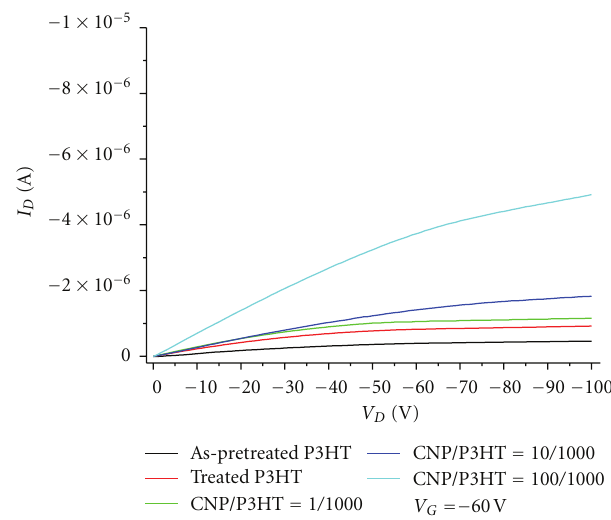
Figure 3: Output characteristics I D -V DS at V GS = − 60V for various CNP/P3HT